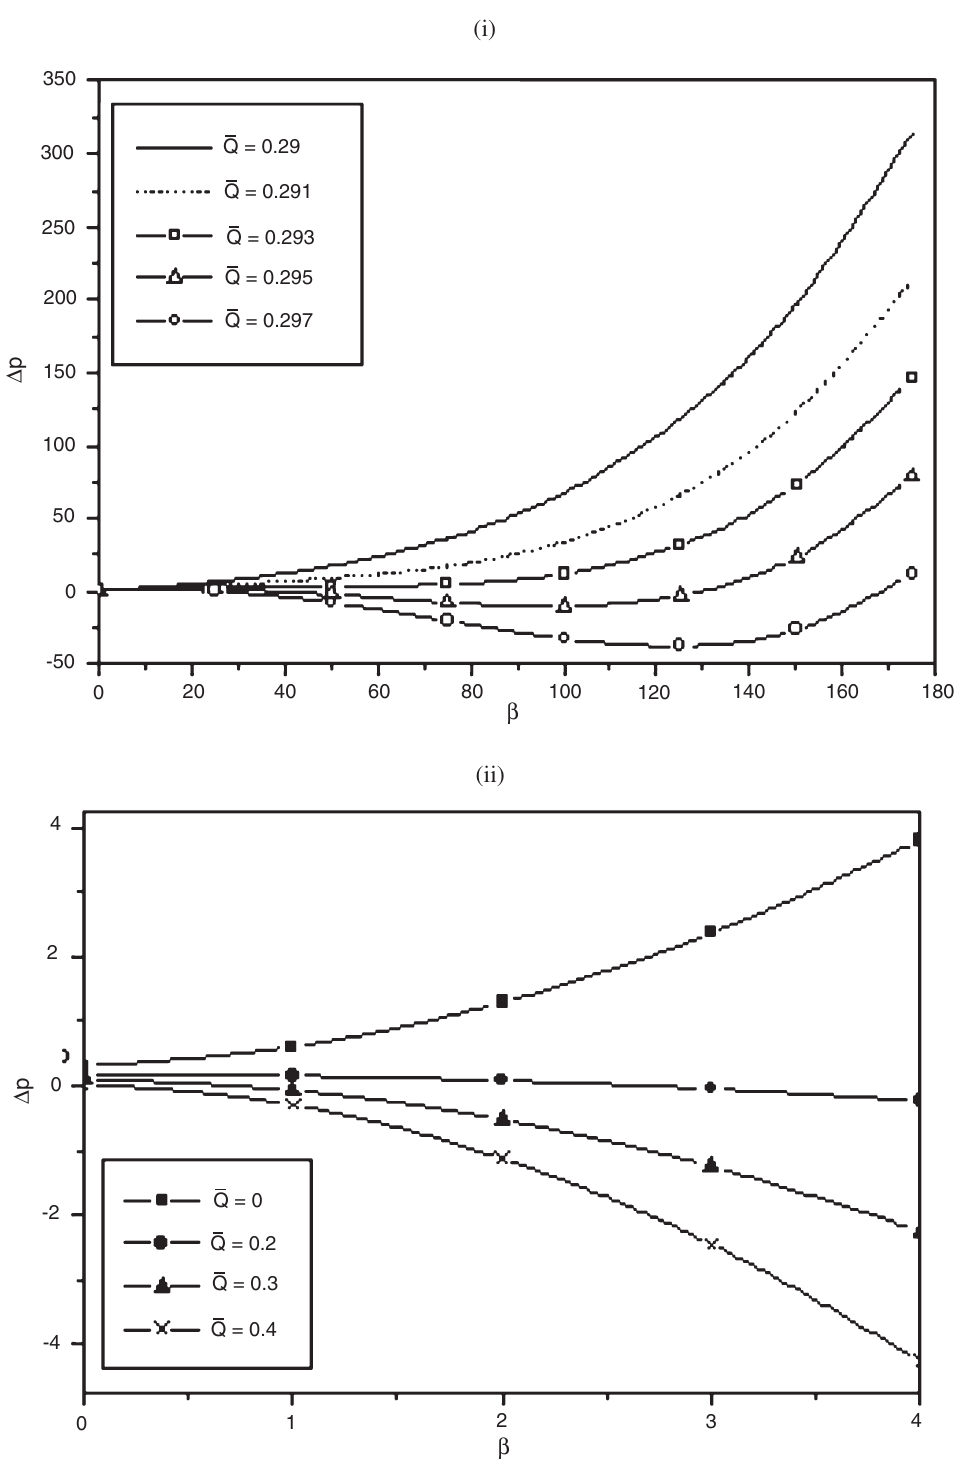
Fig. 4. Variation of (cid:9) p versus β with a = b = 0 . 7 and φ = π/ 4 (i) for different values of flux Q and (ii) enlargement of (i) near β =